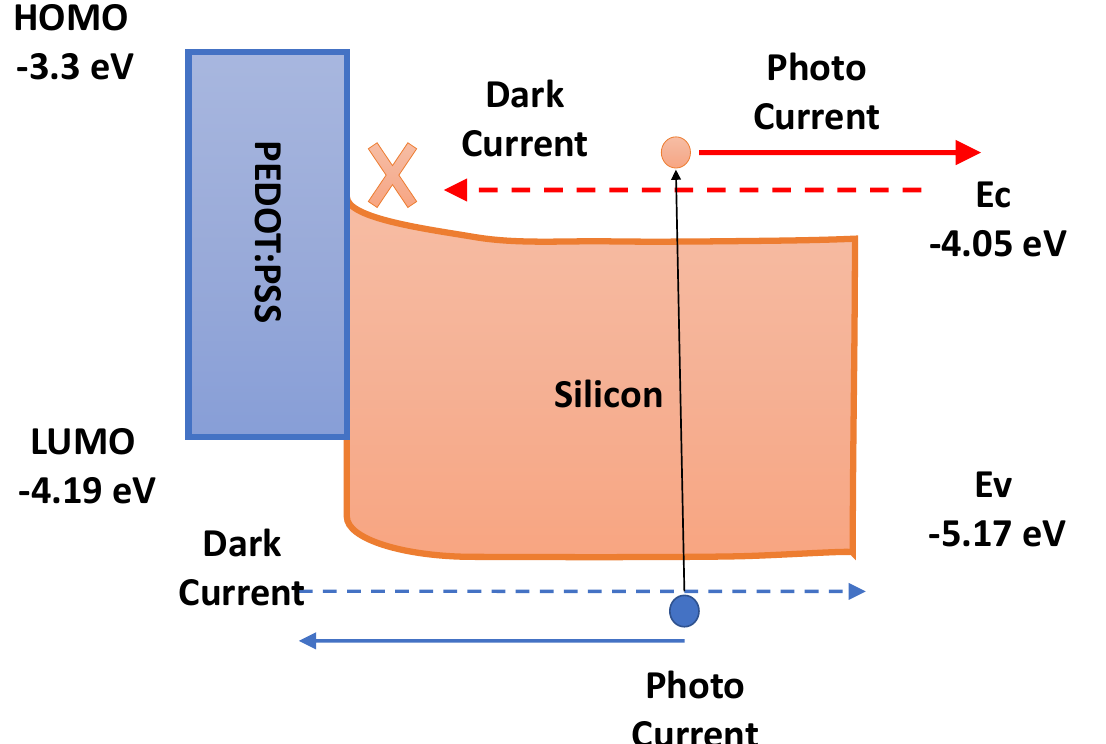
Figure 8. Energy band diagram of PEDOT:PSS–SiNW hybrid solar cell. For simplicity we assume bulk energy bandgap of silicon for band